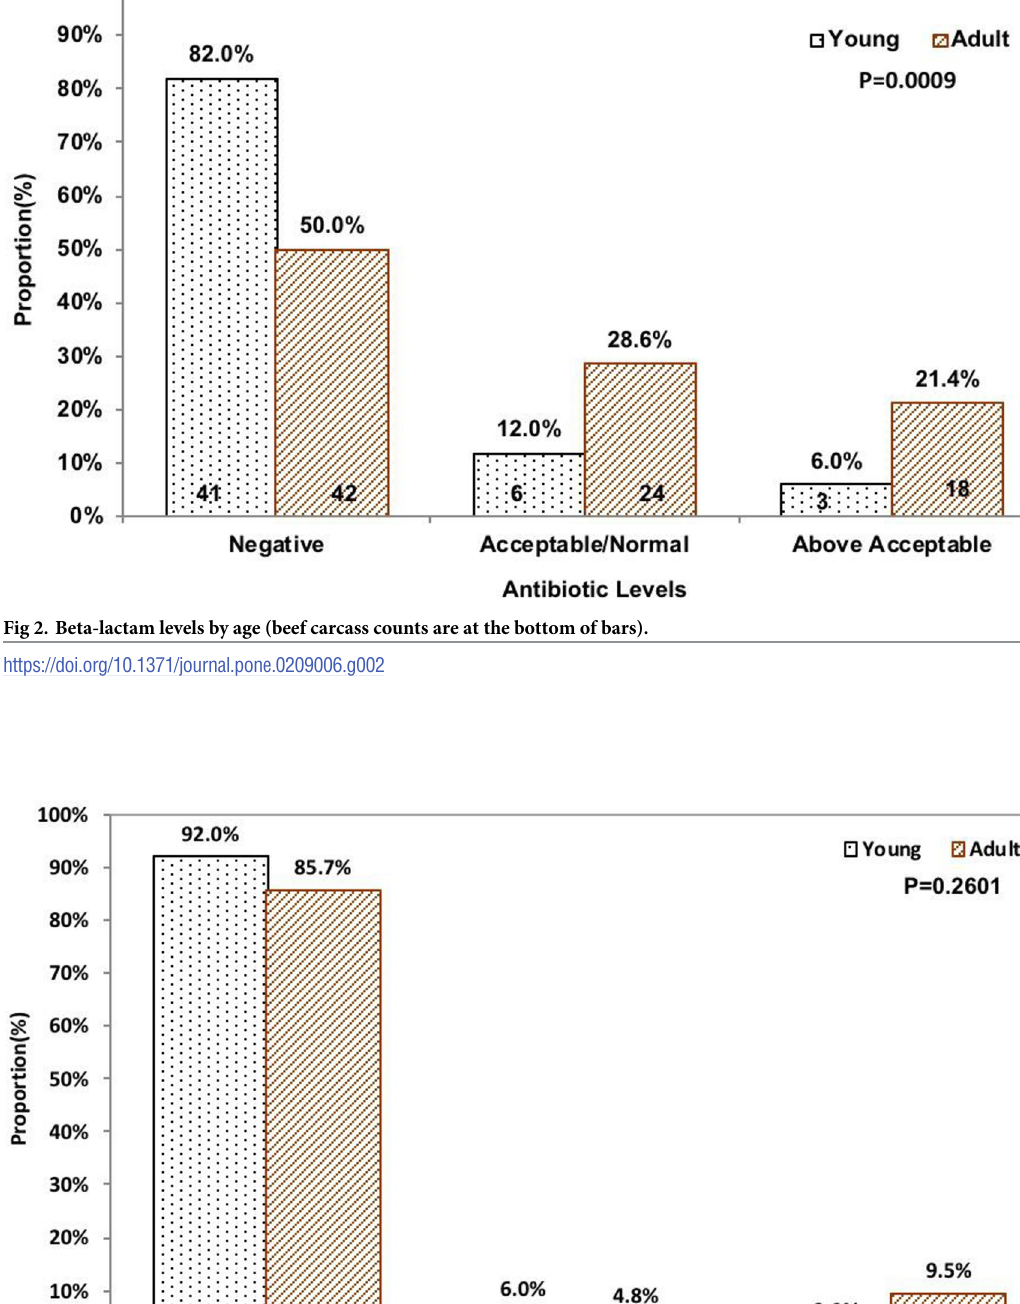
PLOS ONE | https://doi.org/10.1371/journal.pone.0209006 January 10,